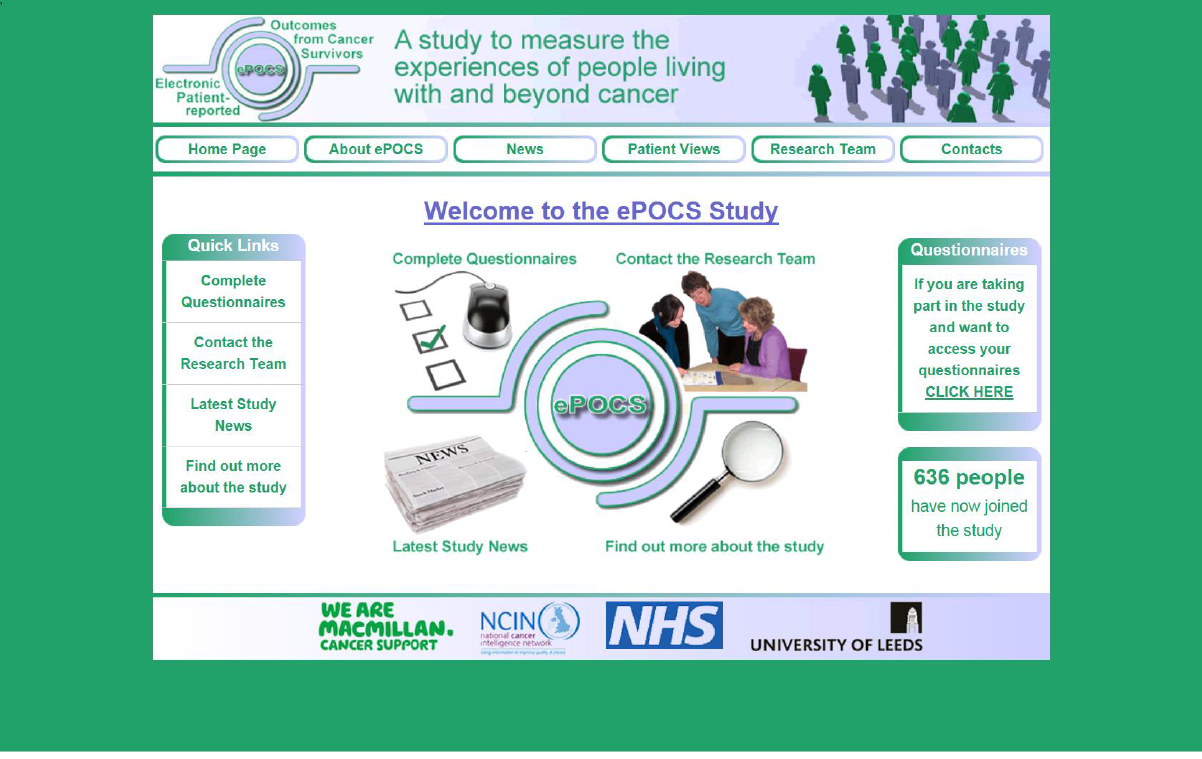
Figure 1. Screenshot of the website homepage of the ePOCS